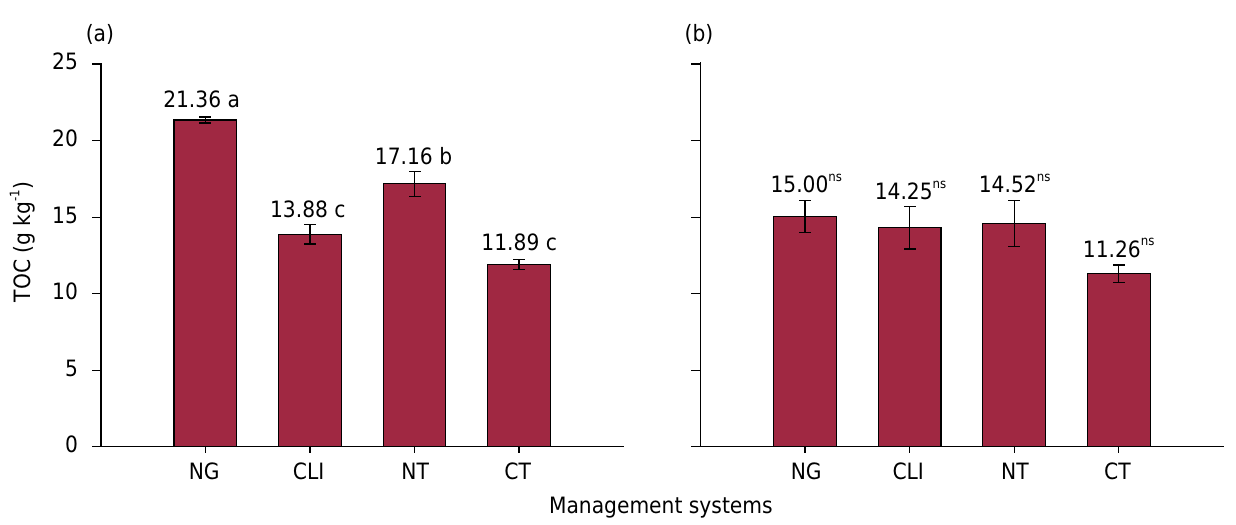
Figure 6. Mean values of total organic carbon content (TOC) of an Albaqualf under different management systems, in the 0.00-0.10 m (a) and 0.10-0.20 m (b) layers. NG: native grassland; CLI: crop-livestock integration; NT: no-tillage; CT: conventional tillage system; ns: no significant. Means followed by the same letter in a column, within each variable and soil layer, were not significantly different from each other by the Duncan test at 5 %. Vertical bars indicate the standard